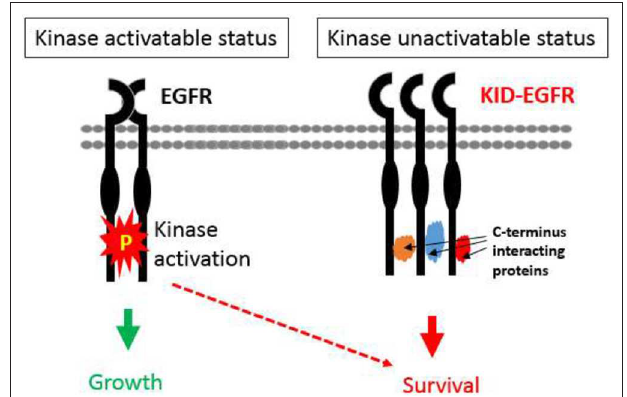
FIGURE 2 | A model of two functional statuses of EGFR in cancer cells. The kinase activatable EGFRs are mainly involved in promoting cell growth, and the kinase unactivatable EGFRs, which are blocked from autocross- phosphorylation by interacting proteins, are mainly in charge of promoting oncogenic cell